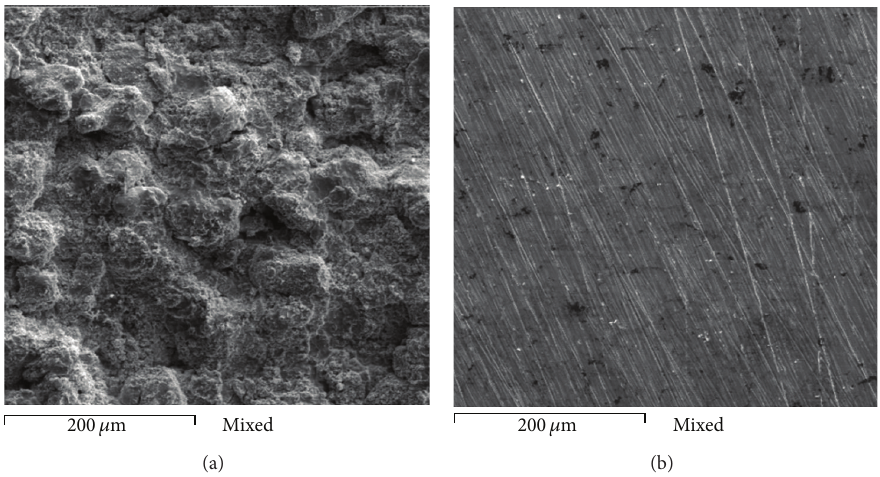
Figure 2: SEM micrographs showing characteristics of the coatings; (a) as-deposited surface and (b) grinded surface.